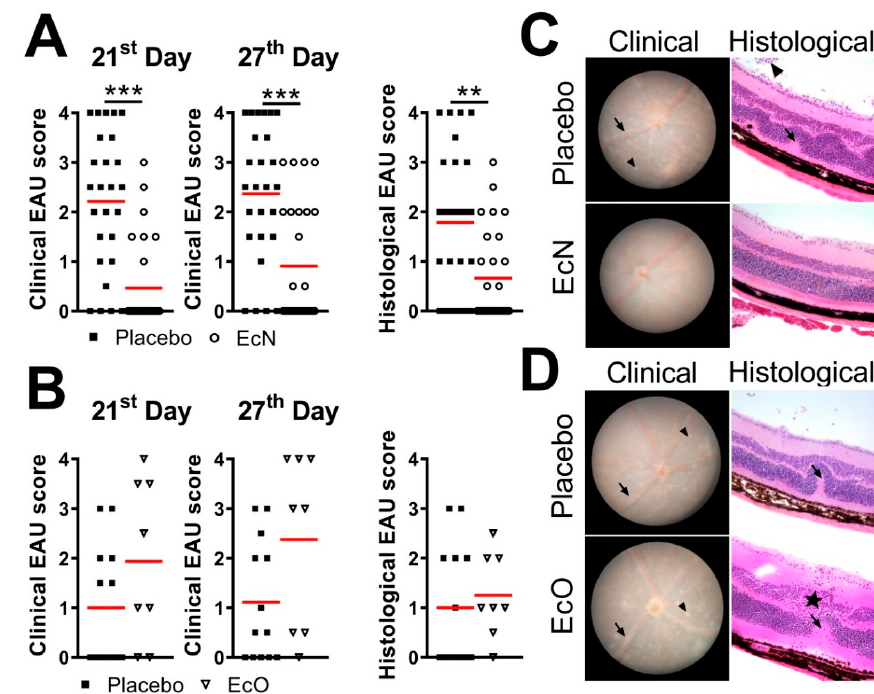
Figure 2. Live probiotic EcN protects from severe forms of EAU when administered starting 14 days before the immunization until day 28 post-induction [ n = 26 (placebo), 28 (EcN) in total] ( A ), while EcO has no effect [ n = 13 (placebo), 8 (EcO) in total] ( B ). EAU severity was assessed by in vivo fundus biomicroscopy on the 21st and 27th day post-induction and by histological analysis 28th day post-induction and the differences were quantified by unpaired Mann Whitney test; graphs show individual values and red lines represent mean, ** p < 0.01 *** p < 0.001. Data are pools from 5 (EcN) or 2 (EcO) independent experiments. Representative pictures from clinical and histological pictures from the 27th day show typical pathological features when mice were treated with EcN ( C ) or EcO ( D ). These include chorioretinal lesions (arrowhead), vascular sheathing (arrow) and optic nerve inflammation during clinical examination and infiltration of cells in the inner retina (star), cell infiltration of the vitreous body (vitritis, arrowhead) and retinal folds (arrow) during histological examination (optical magnification 200×).